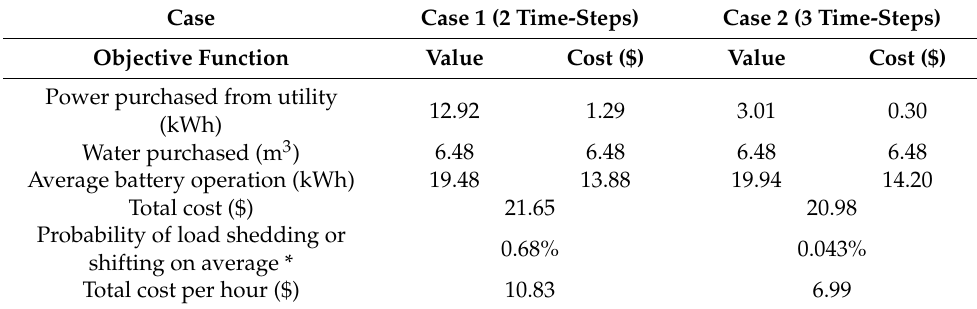
Table 3. Solution of the proposed co-optimization